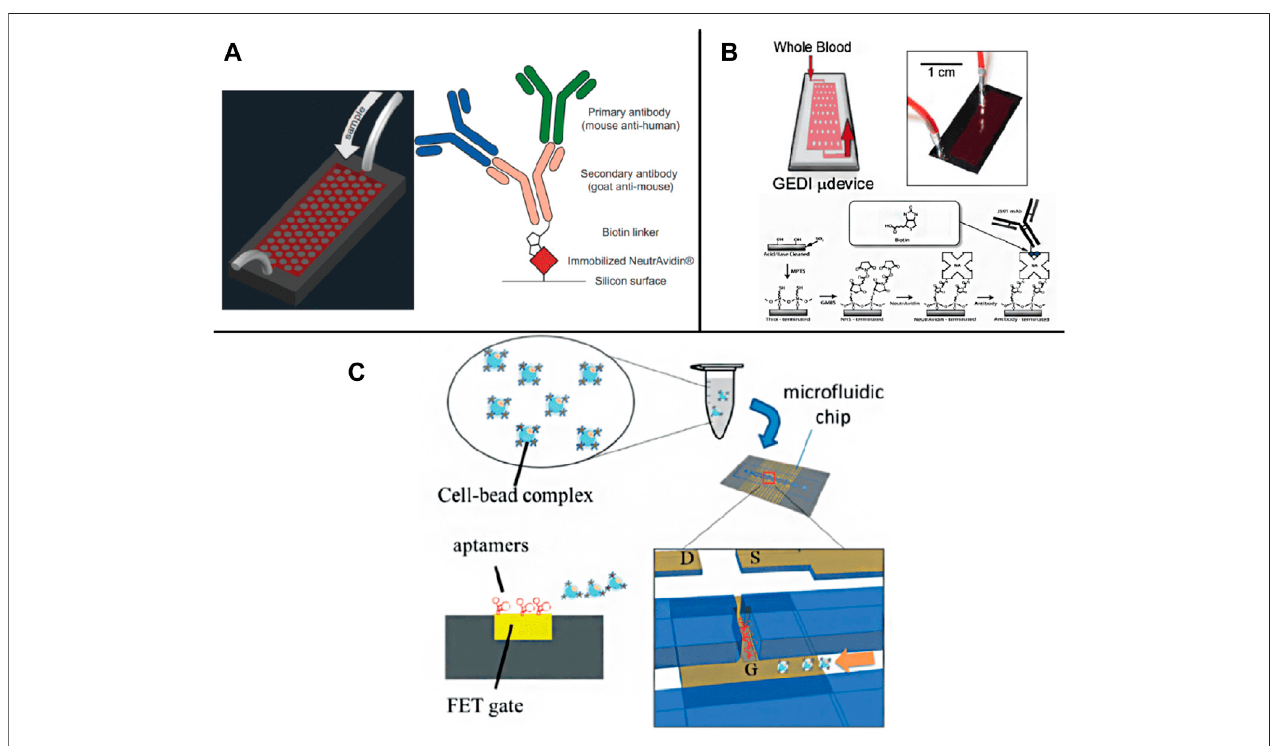
FIGURE 2 | Schematic illustration of membrane antigen and aptamer recognition based chips. (A) A GEDI device combined EpCAM and MUC1 detection (Thege et al., 2014); (B) A GEDI micro fl uidic device for whole blood detection (Kirby et al., 2012); (C) A FET chip for CTC trapping by bonding CTCs to speci fi c aptamer (Chen et al.,